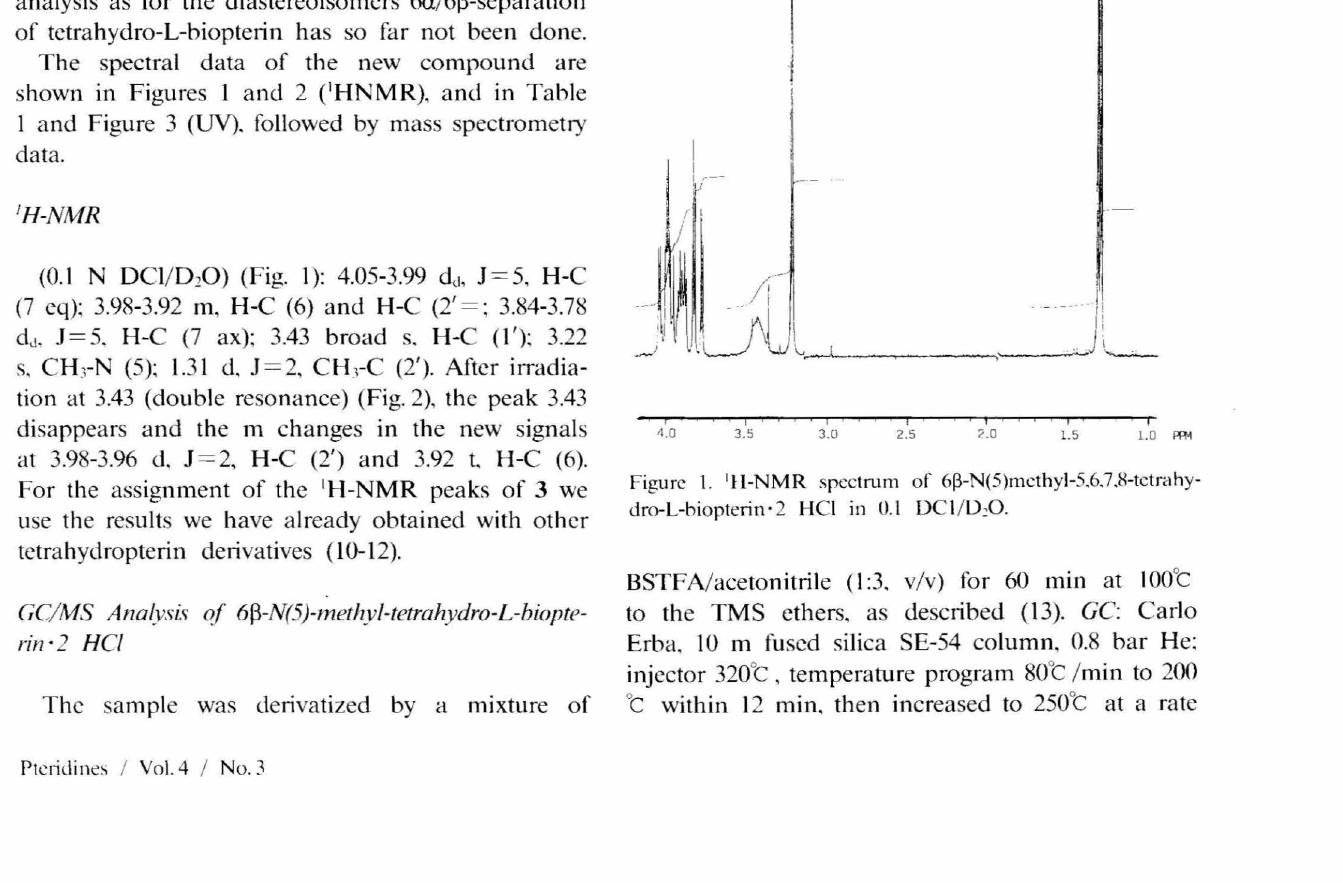
Figure 1. 'H-NMR spectrum of